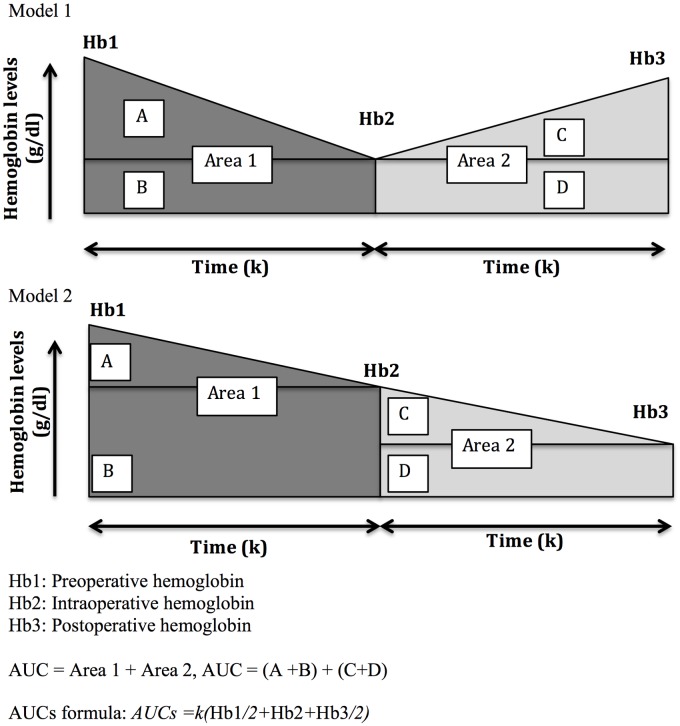
Calculation of perioperative hemoglobin area under the curve (AUC).Hb1: Preoperative hemoglobinHb2: Intraoperative hemoglobinHb3: Postoperative hemoglobinAUC = Area 1 + Area 2, AUC = (A+B) + (C+D)AUCs formula: AUCs = k (Hb1/2+Hb2+Hb3/2)